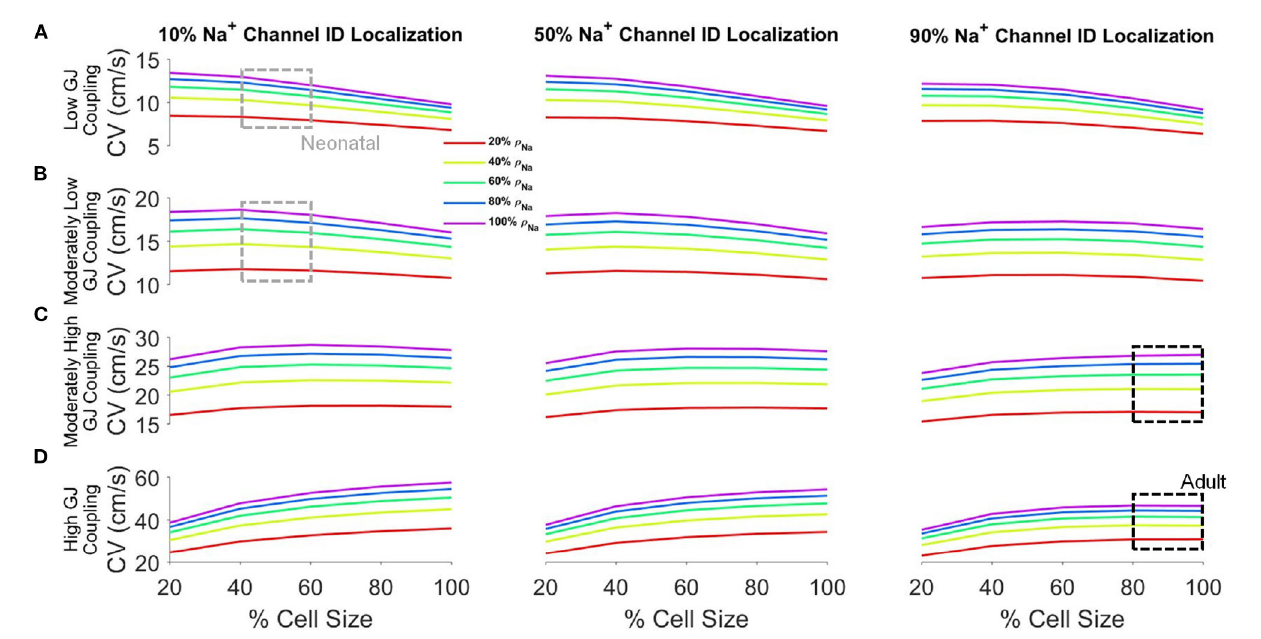
FIGURE 3 | Conduction velocity (CV) depends on key cellular and tissue properties. CV is shown as a function of cell size for different values of Na + channel densities ( ρ Na ) for low (A) , moderately low (B) , moderately high (C) , and high (D) GJ coupling and 10% ( left ), 50% ( middle ), and 90% ( right ) Na + channel ID localization ( ID Na ). Parameters: Cleft width w = 20 nm . Parameter regimes associated with neonatal (gray boxes) and adult (black boxes) tissue are